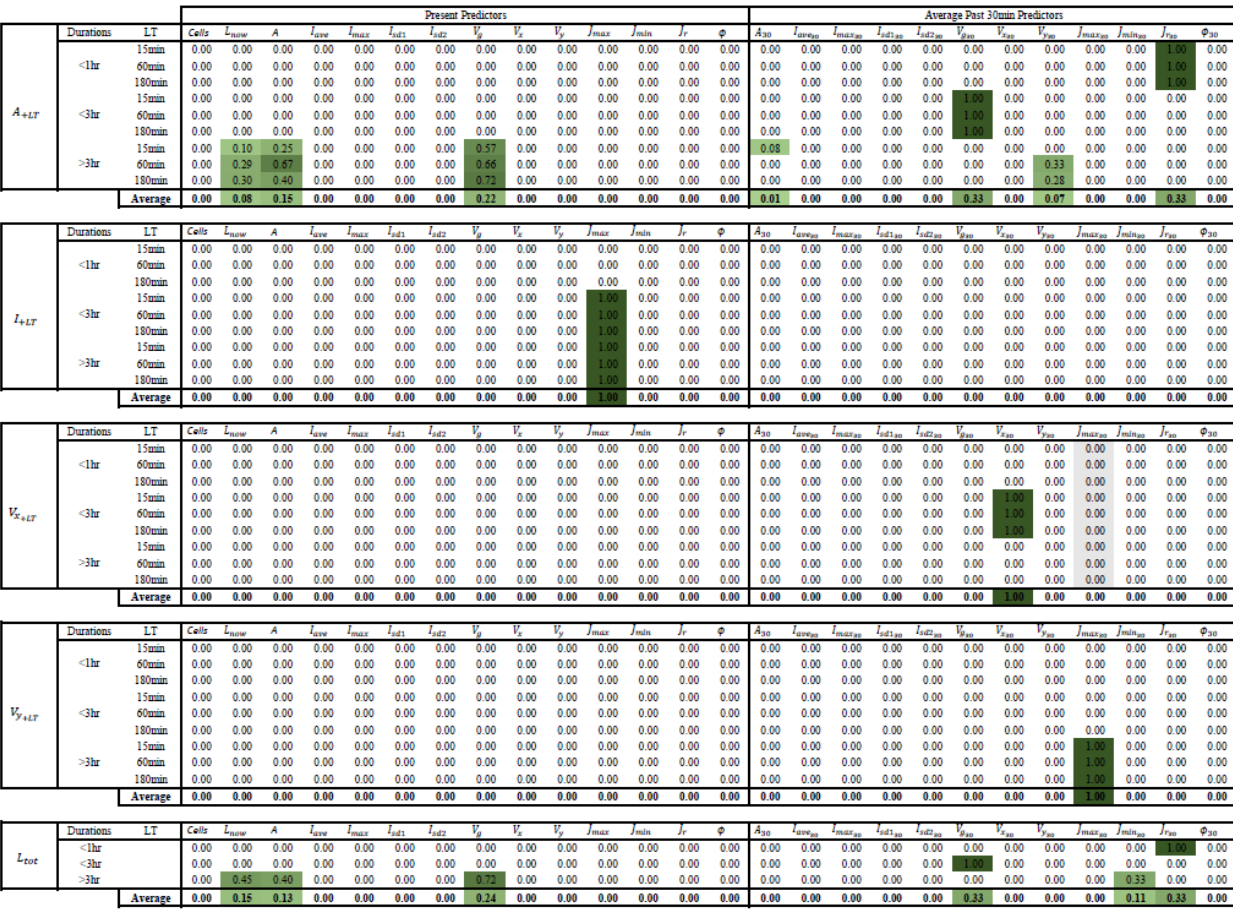
Table A2. Strength of the relationship between the selected predictors and the target variables averaged for three lead times and storm duration groups based on the PIC method. The green shade indicates the strength of the relationship, with 0 for no relationship at all and 1 for the highest dependency. The averaged computed values for each target variable (last row) are used as bases for Table 3: for intensity and velocity in the x and y directions, since the PIC recognized only one predictor as important, and the average value is given as 1 for the selected respective